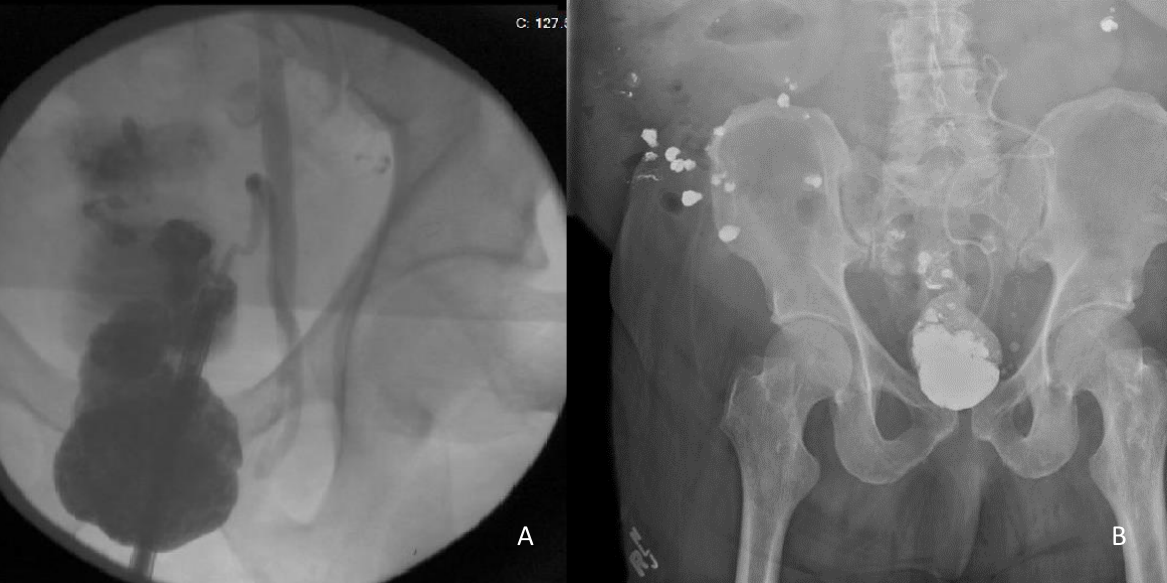
tient, the ureter was presumed to have been located within the hernia sac after delayed identification of a ureteral injury, which resulted in hydronephrosis and drainage of urine from the surgical incision (1). In eight patients (53.3%), who were diagnosed pre-operatively, urologic intervention was attempted pre-operatively, such as retro- grade pyelogram and attempted placement of a ureteral stent (1-4). Ureteral stents were successfully placed in five patients (1, 2, 4), while the other three patients had percutaneous nephrostomy tubes